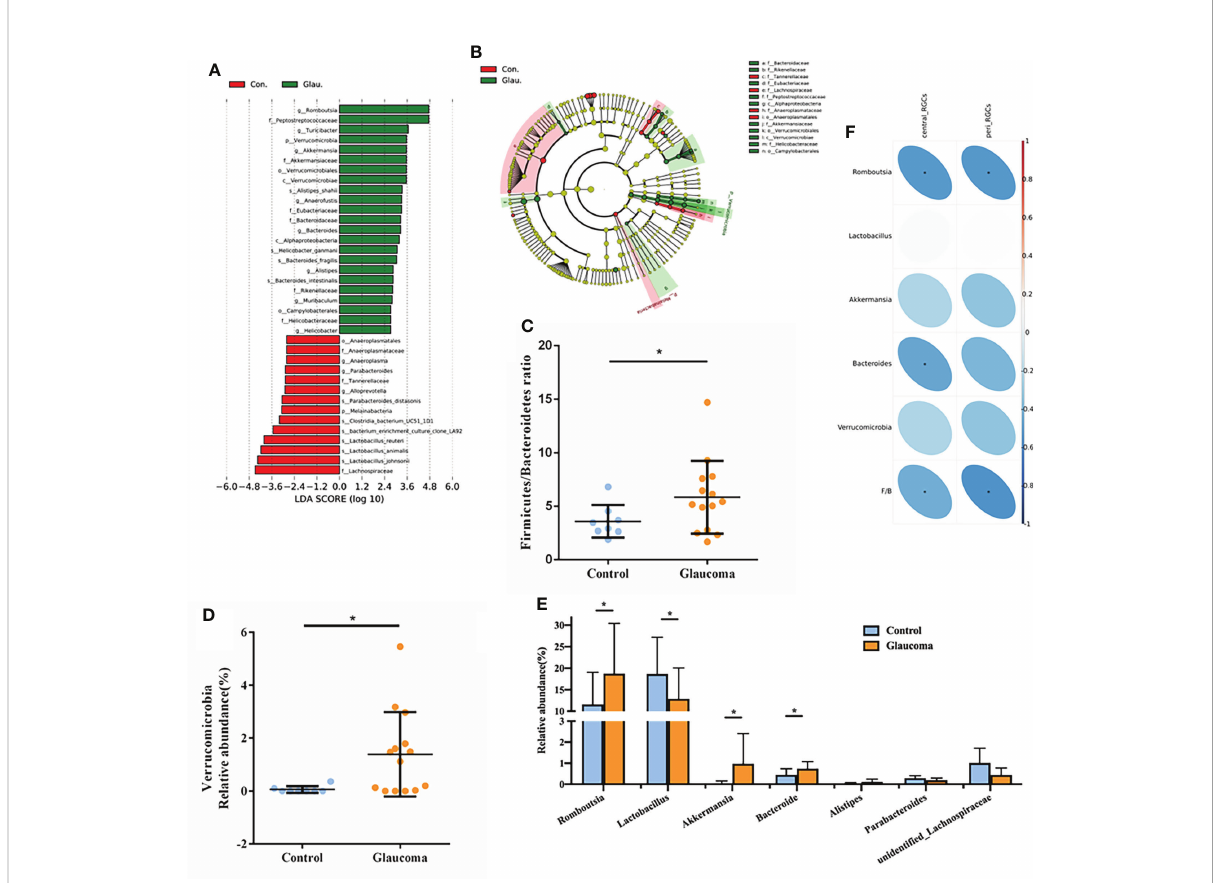
FIGURE 3 Detailed analysis of microbial abundance and its correlation with RGCs. (A) LDA scores (log10) of the bacterial taxa differentially abundant between glaucoma and control rats using LEfSe analysis (LDA > 2.0). Red bars indicate taxonomic enrichment in control rats, and green bars indicate taxonomic enrichment in glaucomatous rats. (B) Cladograms generated by LEfSe analysis indicate different taxonomic levels between control and glaucoma groups. Red circle indicates taxonomic enrichment in control rats, and green circle indicate taxonomic enrichment in glaucomatous rats. (C) Comparison of the Firmicutes/Bacteroidetes ratio in glaucoma and control groups. *P<0.05. (D) Relative abundance of the Verrucomicrobia phylum in glaucoma and control groups. *FDR-corrected q<0.05 (E) Relative abundance of the 7 genera differentially enriched in glaucoma and control groups (all P<0.05, *FDR-corrected q<0.05). (F) Spearman ’ s correlation analysis is done and heatmap shows the correlation between differential bacteria and central/peripheral RGCs. Correlation coef fi cient is on the right side, and red indicates positive correlation and blue indicates negative correlation. RGC, retinal ganglion cell; LDA, linear discriminant analysis; LEfSe, linear discriminant analysis effect size; FDR, false discovery